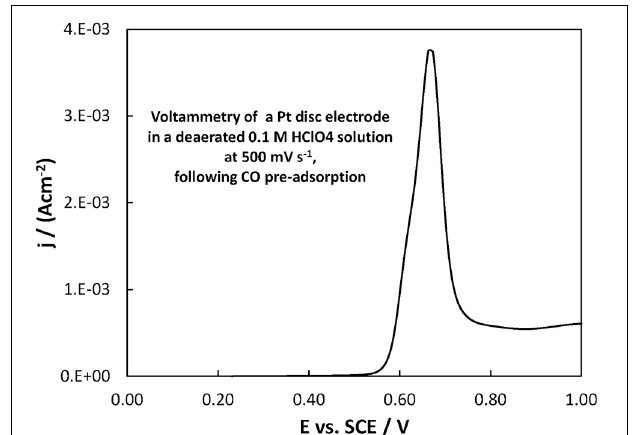
FIGURE 11 | Voltammogram of a Pt disc electrode in a deaerated 0.1M HClO 4 solution at 500mV s − 1 , following the procedure for CO monolayer adsorption and subsequent oxidation described in section Electrochemical characterization of coatings. The scan initiated at + 0.20V toward more positive